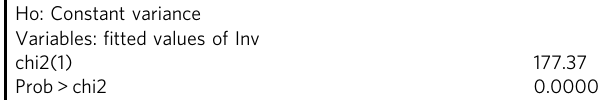
Table 7 The results of Breusch – Pagan/Cook – Weisberg test for